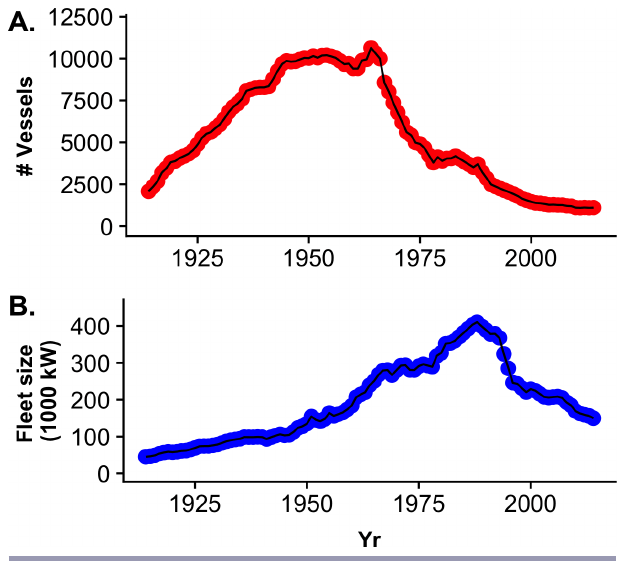
Fig. 3 . Size of the Swedish fishing fleet 1914–2014. (A) Number of vessels, which is roughly proportional to the number of commercial fishers. (B) Sum of engine power (1000 kW). Fleet subsidies have also supported effort-increasing technologies that are not reflected in our measure of the fleet, such as improved gear, sonar (fish finding) technology, navigation, and onboard facilities such as freezing technology, which suggests that our way of measuring fishing capacity is